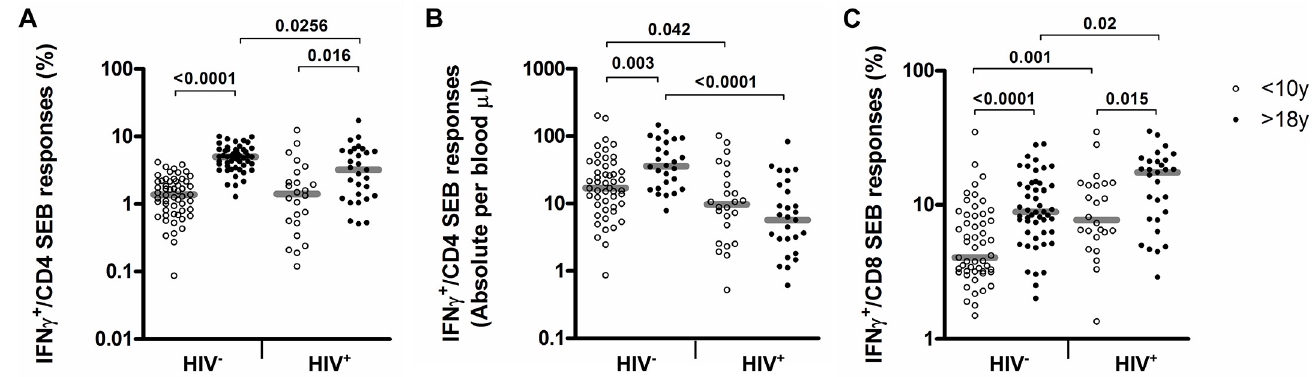
Fig 4. Frequencies and absolute counts of IFN γ + -SEB – specific CD4 + or CD8 + T cell in children below 10 years of age and adults. Scatter-plots depicting A) the frequencies or B) absolute counts of SEB specific IFN γ + -CD4 + T cells s and C) frequencies of SEB specific IFN γ + -CD8 + T cells in the two- age groups and according to HIV